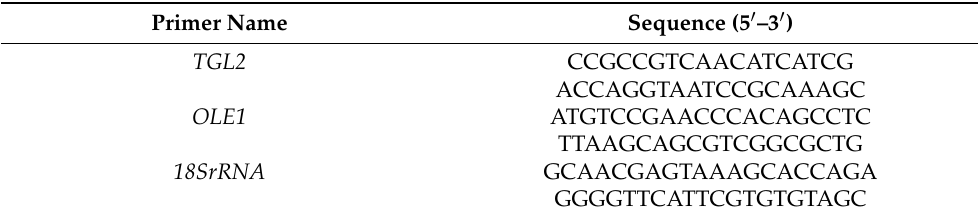
Table 1. Primer sets used in